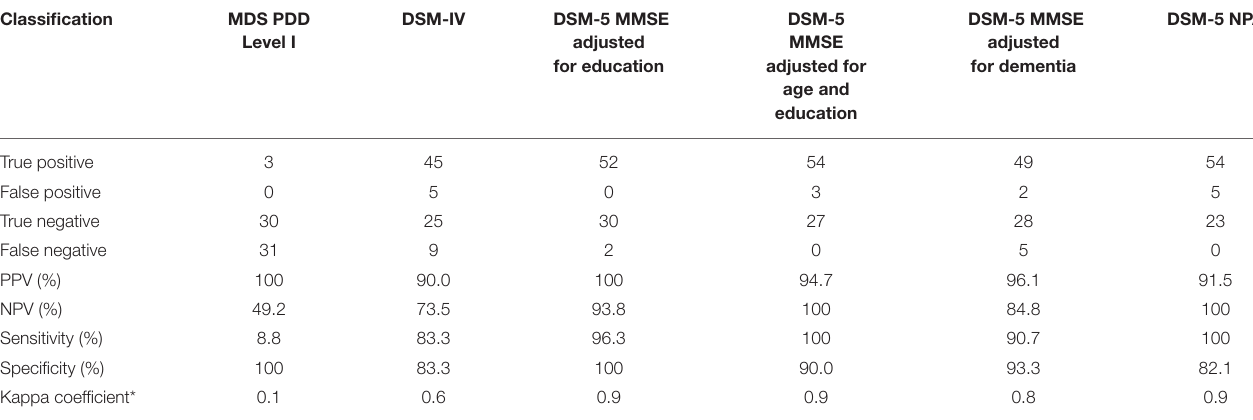
TABLE 5 | Classification of LSPD by different diagnostic criteria using MDS PDD Level II criteria as the gold-standard.